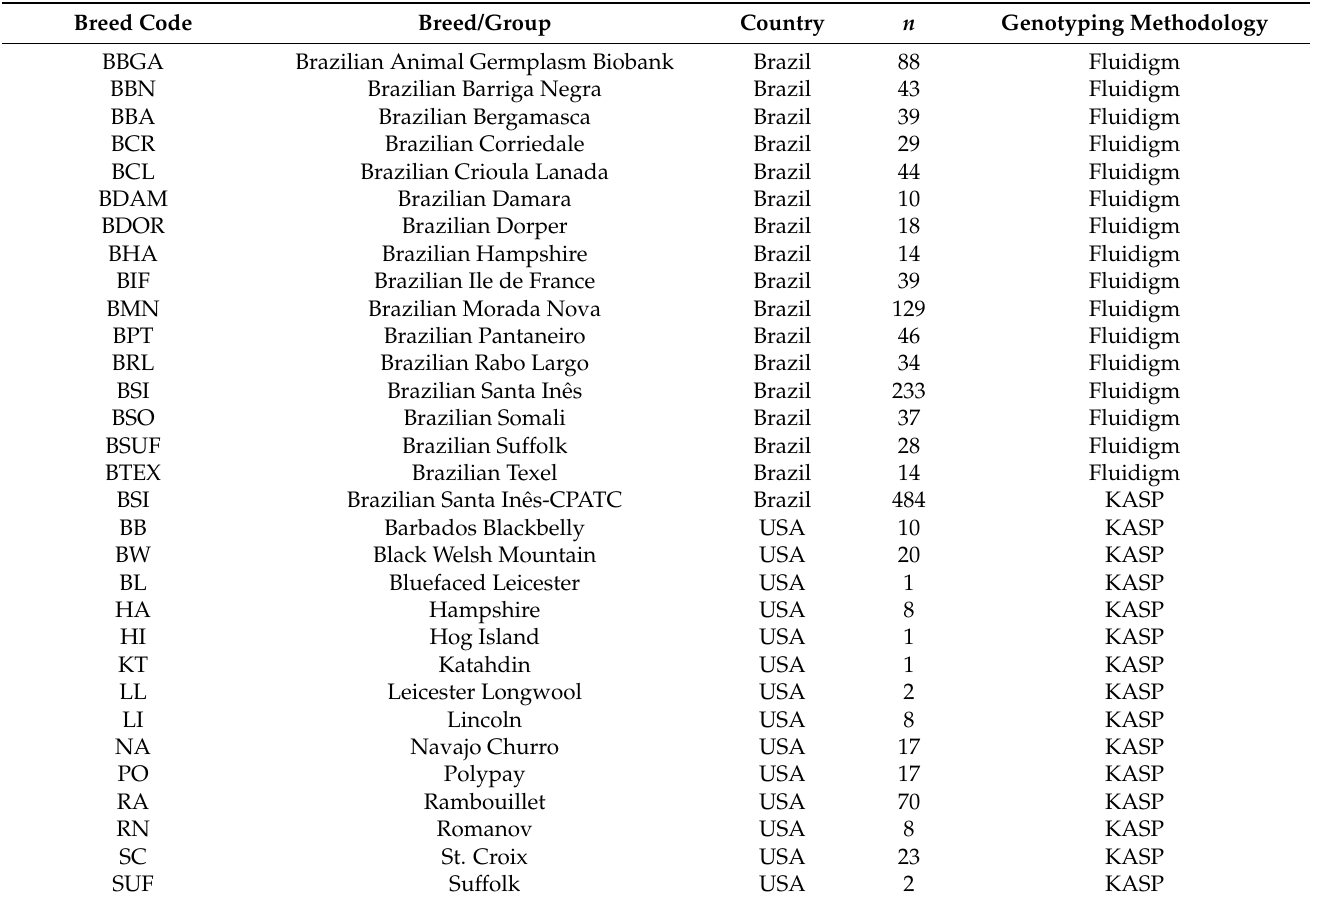
Table 1. Methodology and number of samples used in the present study according to sheep breed and country of